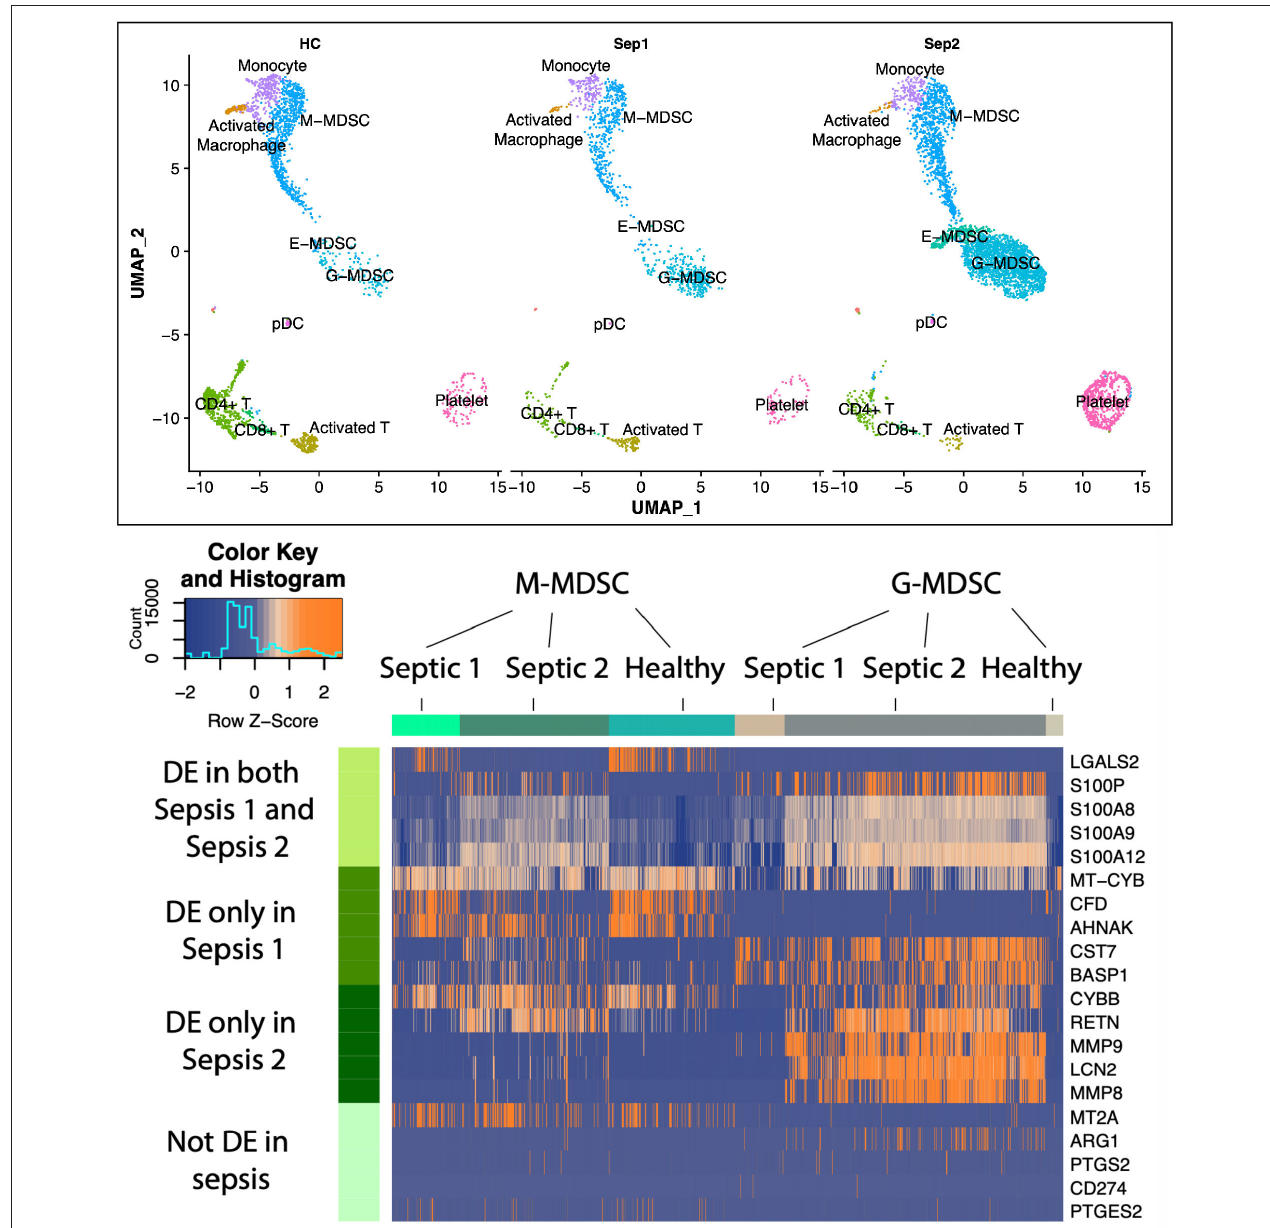
FIGURE 5 | Uniform manifold approximation and projection (UMAP) plots of cell clusters identified in healthy patients ( n = 2,340 cells) vs. sepsis 1 (bacteremia, sepsis; n = 1,544 cells) and sepsis 2 (fungemia, septic shock; n = 5,587 cells) showing three distinct MDSC subsets. Heatmap illustrating expression patterns of MDSC subsets at 21 days post-sepsis vs. healthy control subjects. Rows represent the specific genes of interest differentially expressed in both sepsis patients; only sepsis patient 1; only sepsis patient 2; and genes not differentially expressed in this study, but previously determined to be important to MDSC function in cancer and autoimmunity. Number of columns represent number of cells analyzed in each group. DE, differentially expressed genes in sepsis vs. healthy controls. Colors represent mean normalized relative expression with blue representing reduced expression and orange, increased expression. Modified from Darden et al.